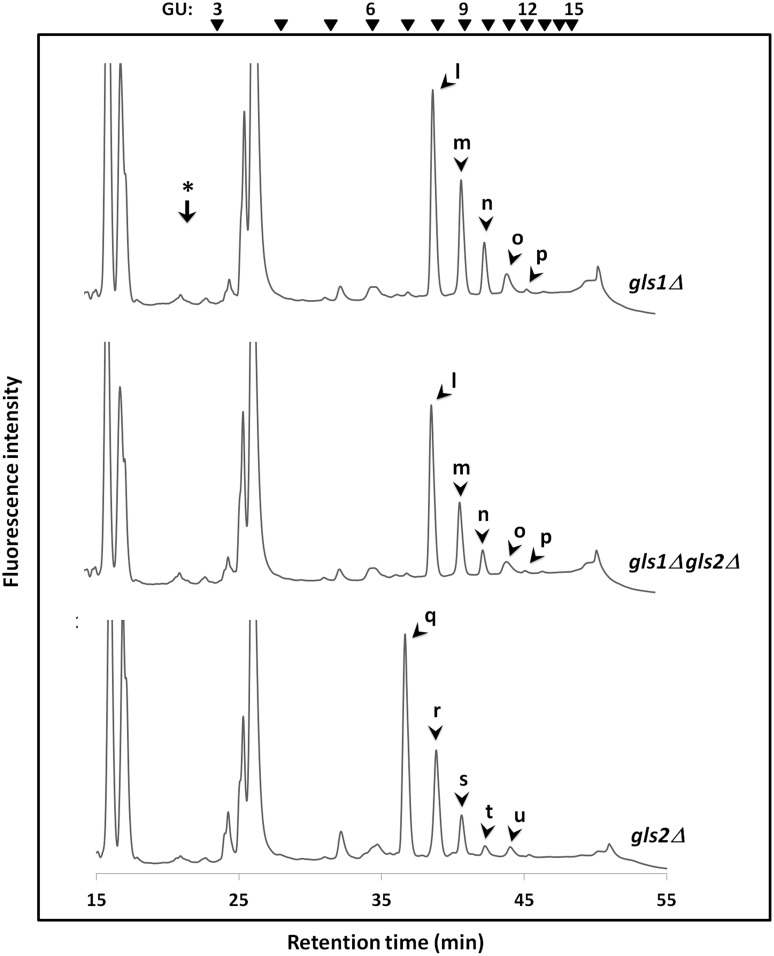
Size-fractionation HPLC profiles of PA-labeled FNGs derived from the glucosidase mutant cells in stationary phase.Peaks 'l-p' produced in gls1Δ and gls1Δ gls2Δ cells, correspond to Glc3Man4-8GlcNAc2-FNGs, whereas peaks 'q-u' produced in gls2Δ cells correspond to Glc2Man4-8GlcNAc2-FNGs. The arrowheads indicate the elution position of PA-glucose oligomer for elution standards. The arrow with the asterisk shows the elution position of Man1GlcNAc2.